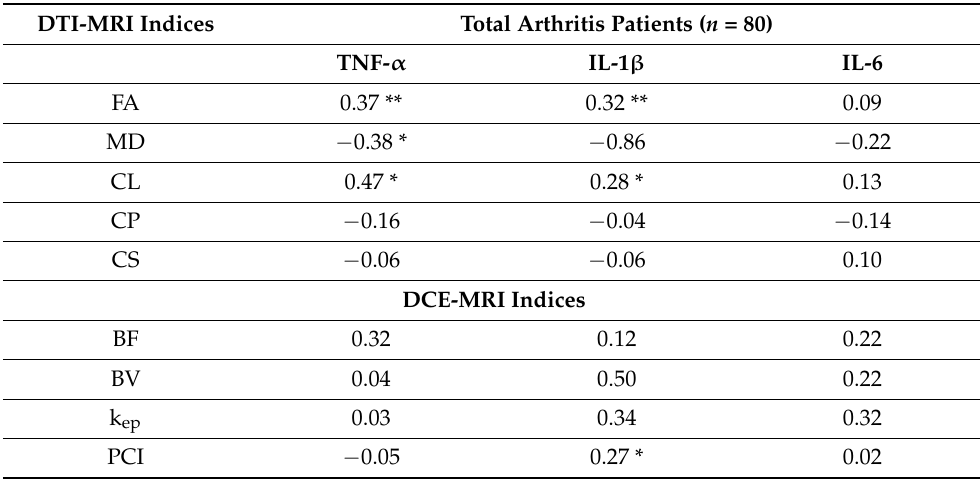
Table 5. Correlation between DTI and DCE indices with proinflammatory cytokines in the synovial fluid. Results are expressed as R values.